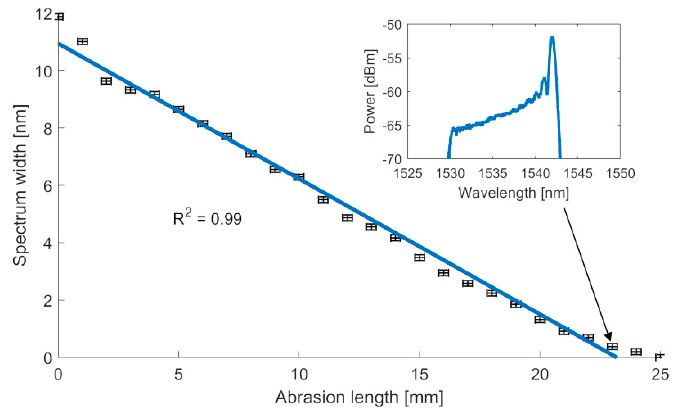
Figure 9. Spectrum width—abrasion relation graph.